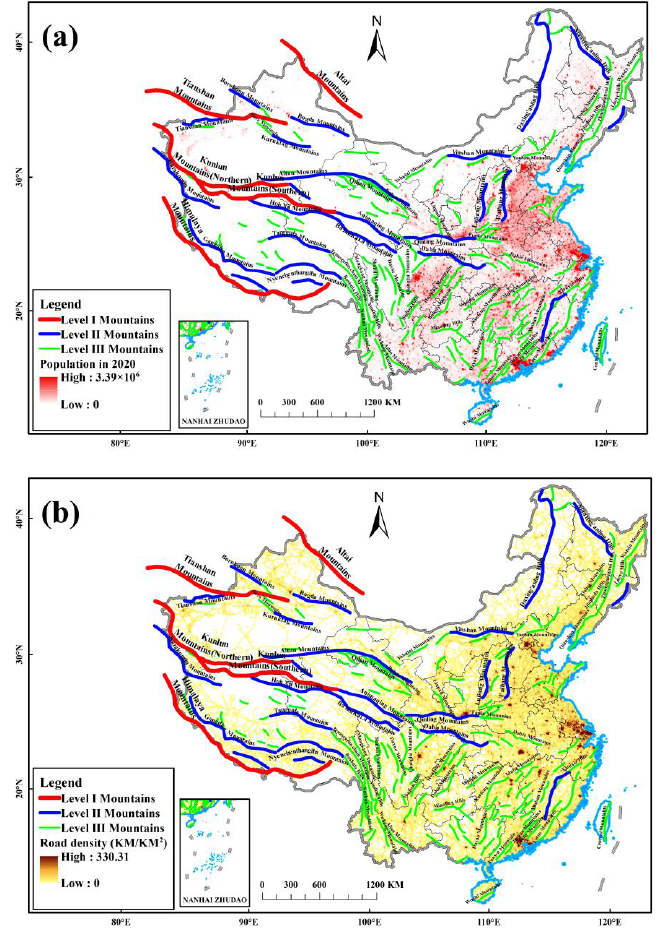
Figure A4. Population counts and road density map in China. The population counts map originated from the WorldPop Hub, and was resampled from 100 m to 8 km. The road density map was provided by Global Roads Inventory Project (GRIP) dataset at an 8 km resolution. ( a , b ) are the Map of South China Sea Islands.